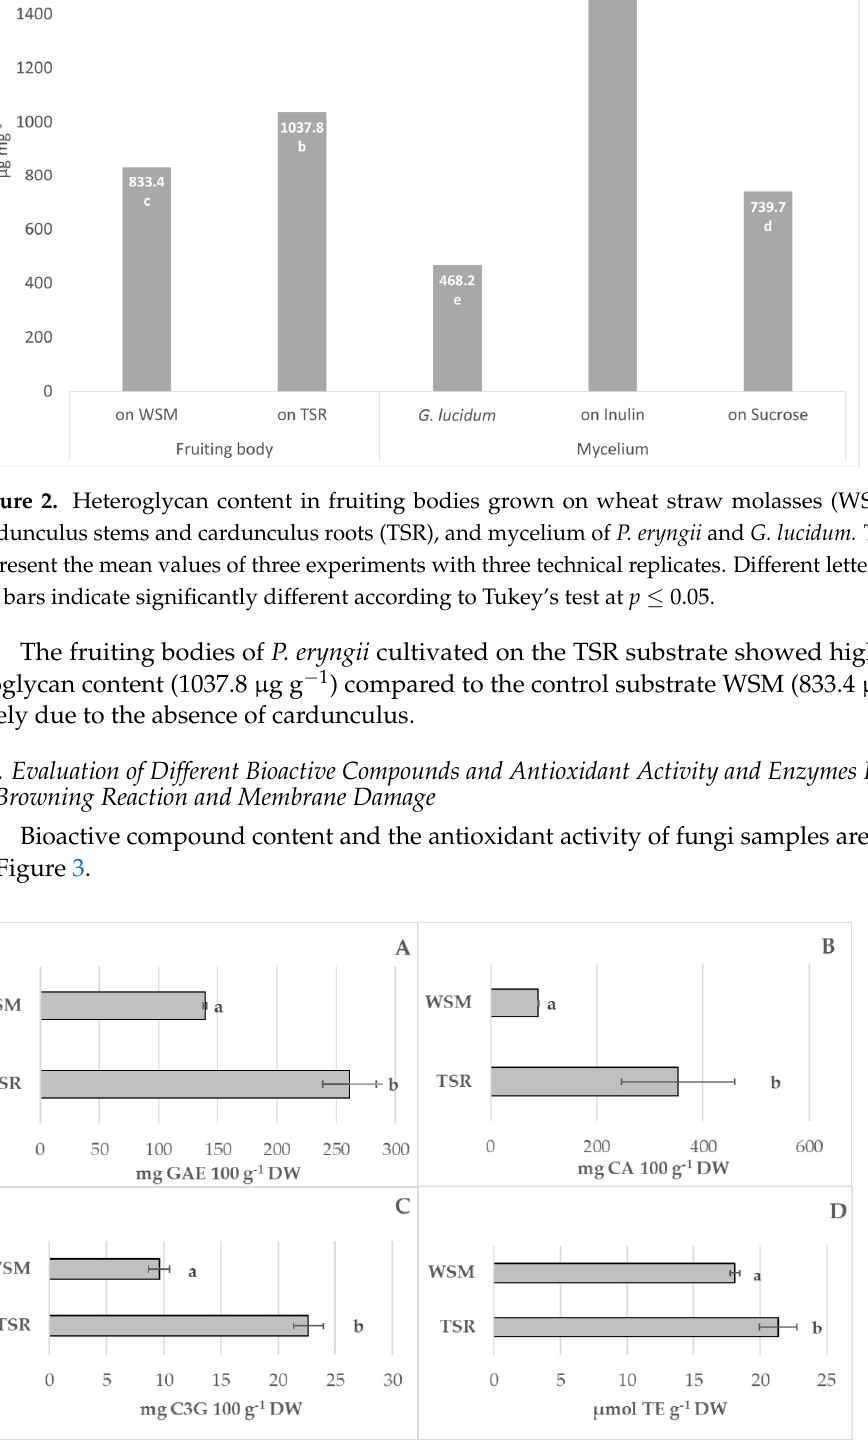
Figure 3. Total polyphenol ( A ), total flavonoids ( B ), total anthocyanin ( C ), and antioxidant activity ( D ) in P. eryngii obtained by two different substrates (WSM and TSR). The data represent the mean values of three experiments with three technical replicates. Means with the same letter are not significantly different according to Tukey’s test at p ≤ 0.05.